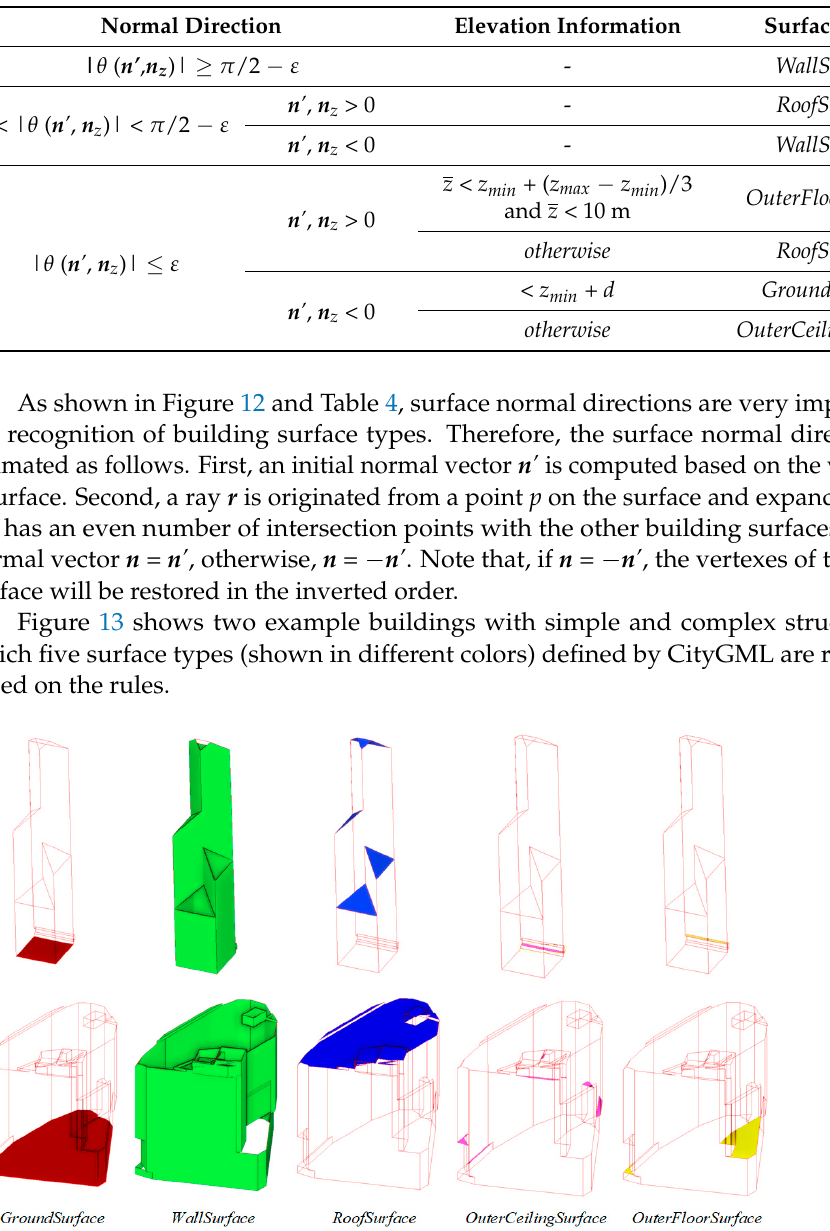
Figure 13. Surface type recognition with two example